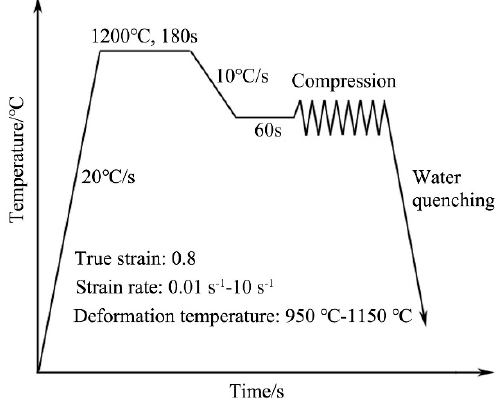
Figure 2. Schematic diagram of the hot compression test procedure.